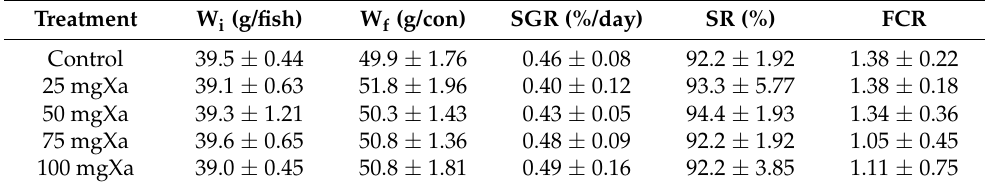
Table 5. Growth performance, initial weight (W i ), final weight (W f ), specific growth rate (SGR), survival rate (SR), feed conversion ratio (FCR) of bighead catfish fed various xanthophyll diets for 4 weeks.